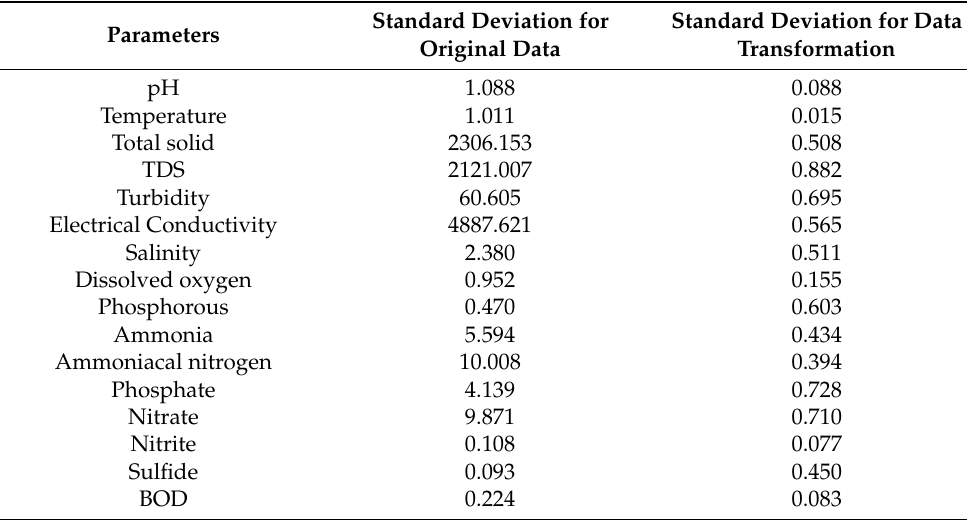
Table 2. Comparison of standard deviation for original data and after log